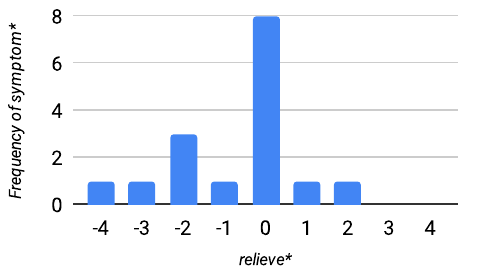
Fig. 7 Distribution of lemma of SYMPTOM with respect to conjugations of verb at node = 0. Verb relieve with symptom in English core corpus, standard deviation from mean, μ = − 1.38, σ = 2.0. Starred items denote noun and verb forms rather than